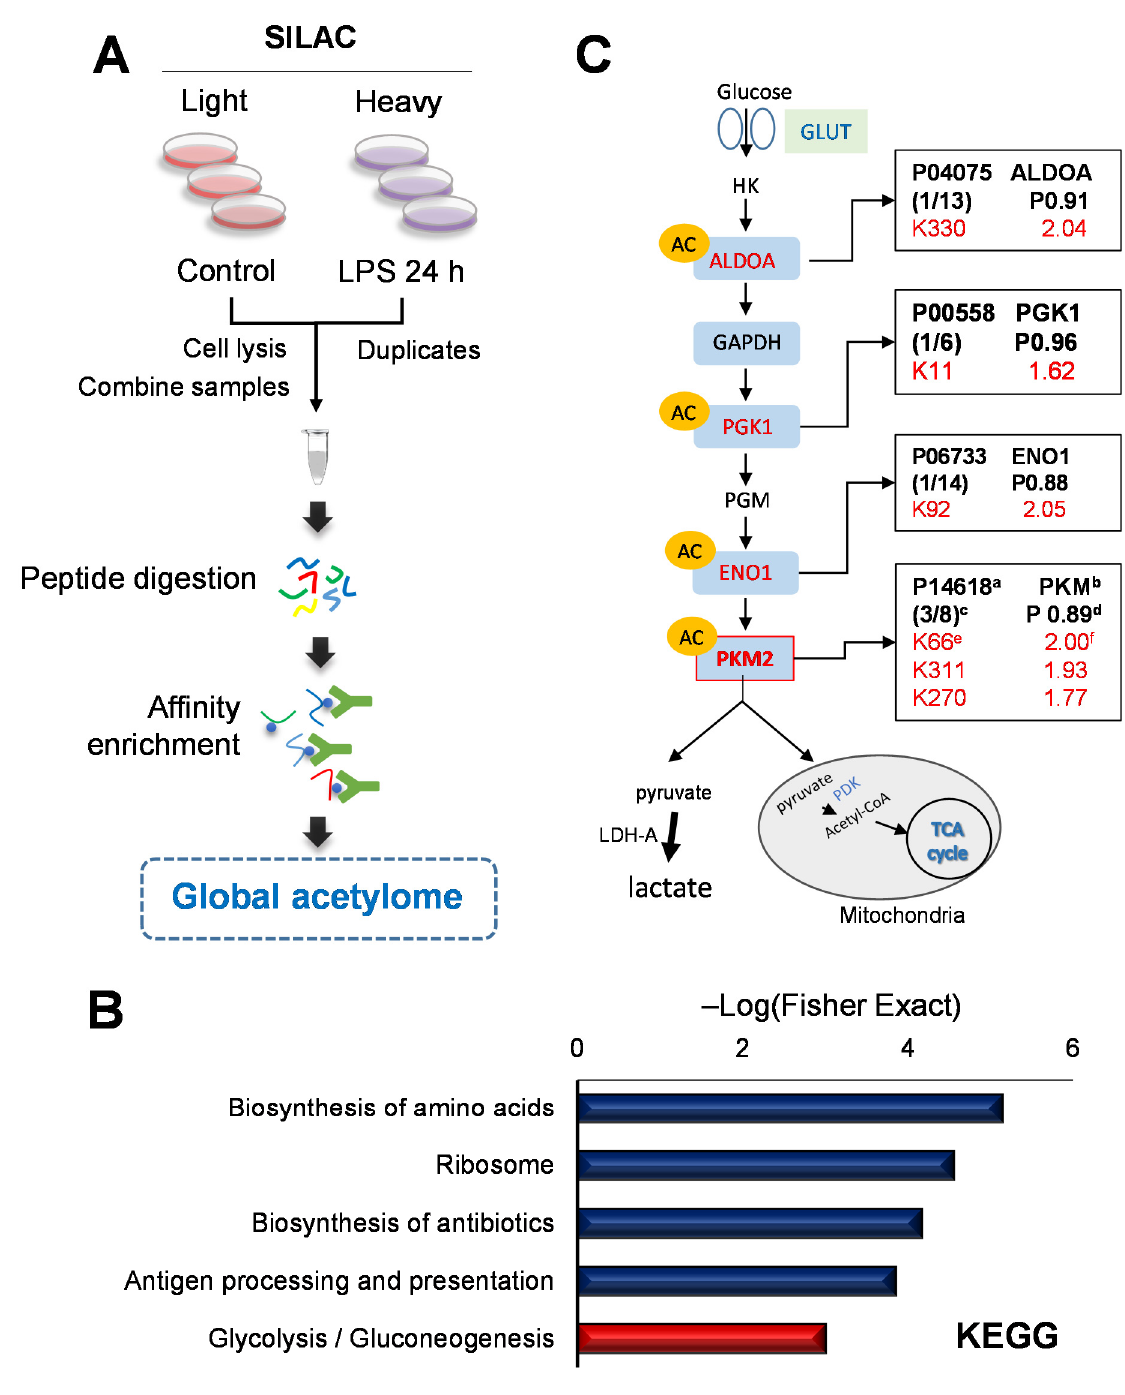
Figure 3. Characterization of lysine acetylation (Kac) in sepsis-induced liver dysfunction (SILD) in human hepatoma cells. ( A ) For the global lysine acetylome study, control (“light”, K0R0) and 1 μ g/mL LPS treatment for the 24 h (“heavy”, K8R10)